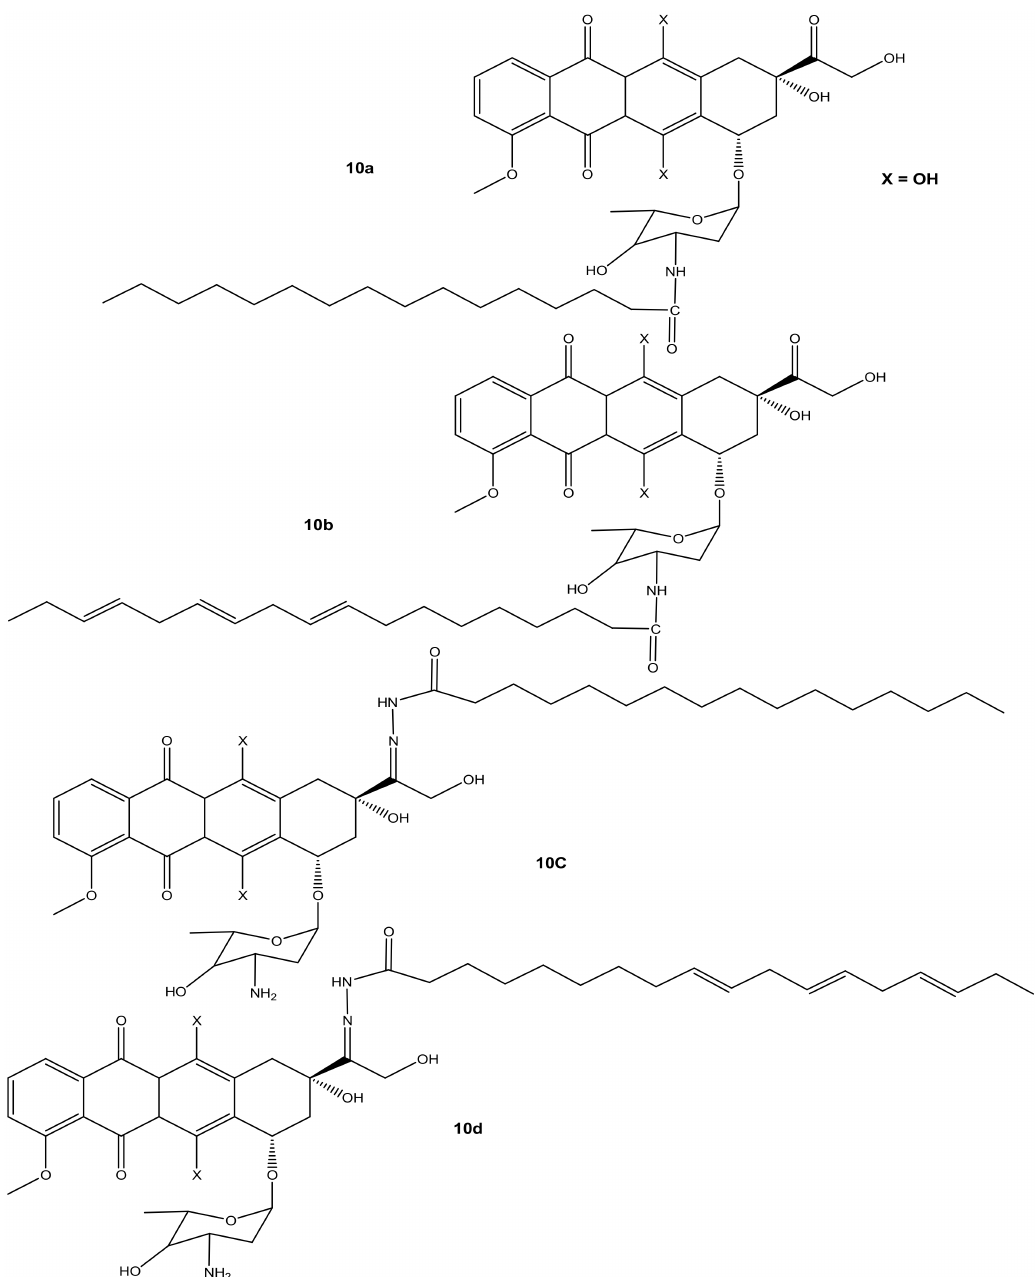
Figure 6. Chemical structures of doxorubicin-PA- α -LA derivatives conjugated via amide bond and hydrazone bond formation ( 10a – d